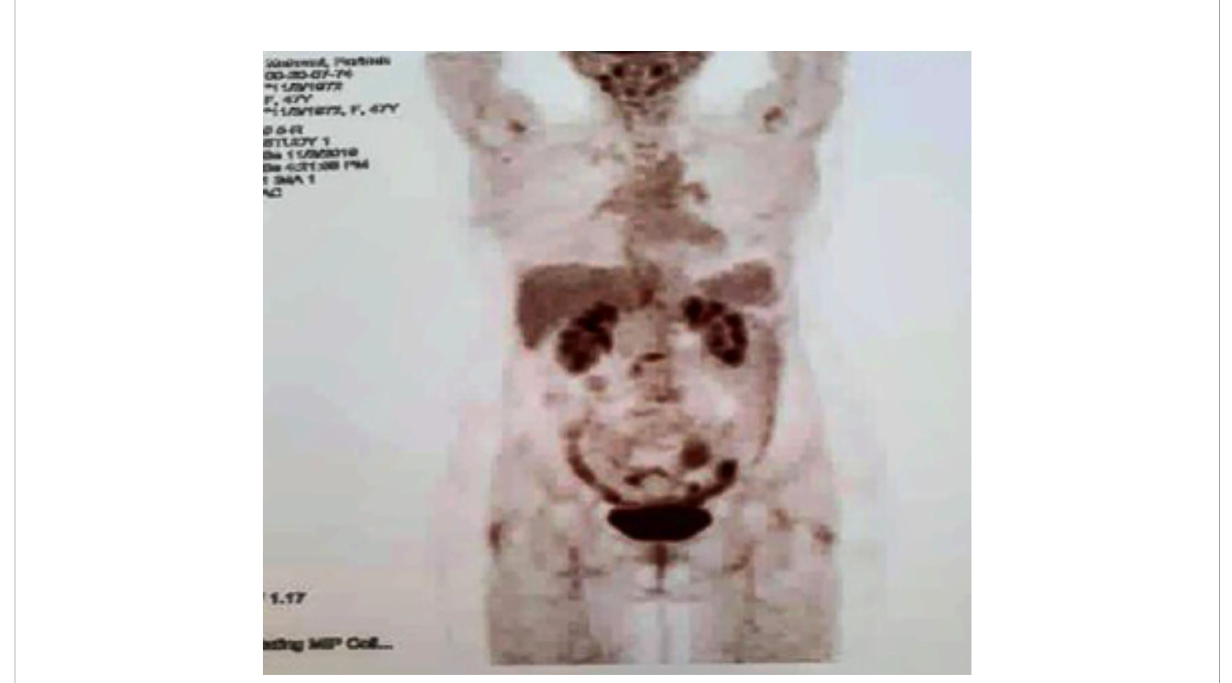
FIGURE 4 Third PET/CT on 03 November 2019. No metabolic evidence of malignancy in the images of the target parts of the body, which was compatible with continued remission.